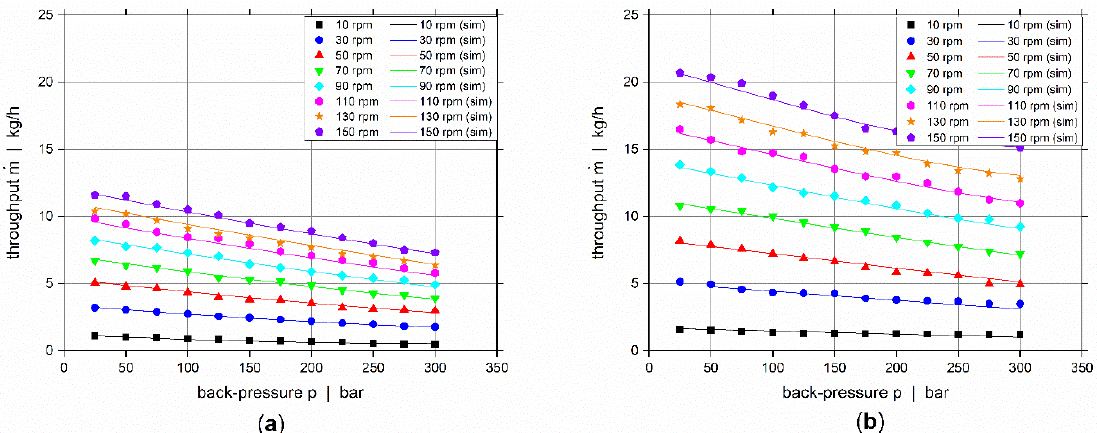
Figure 5. Screw characteristics: comparison of regression models with the experimental data for ( a ) polymer, and ( b ) compound. Experimental data is depicted by the points, and the approximation by the regression models using lines.